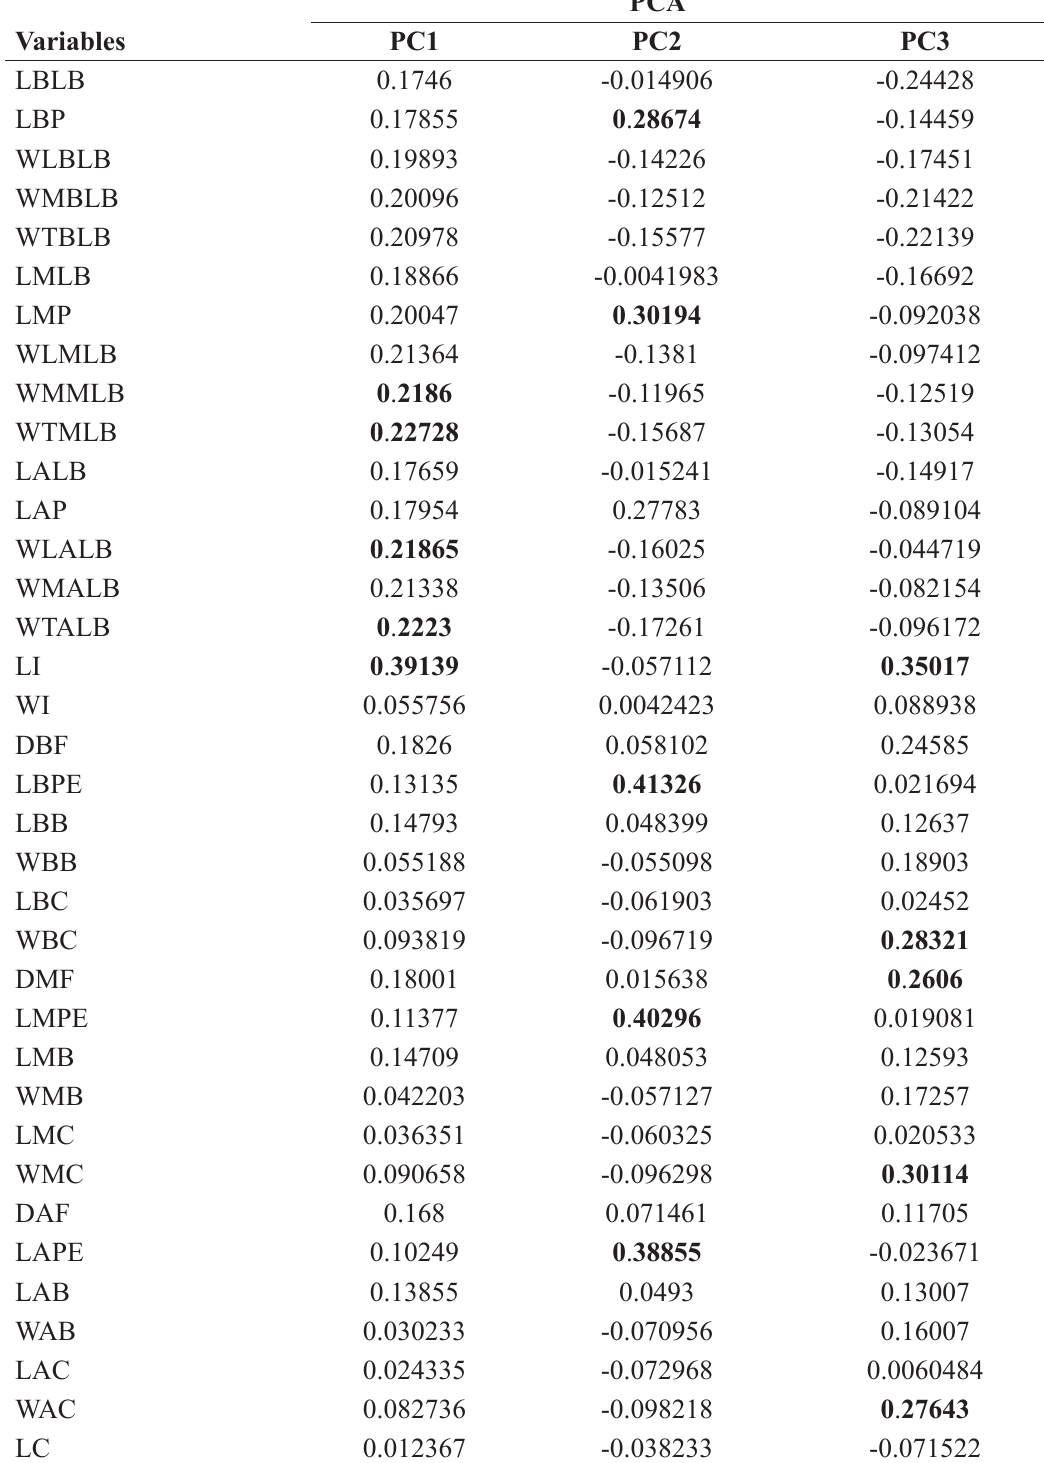
Table 4. Results of Principal Components Analysis (PC1, PC2 and PC3). The five most important (largest) values for each component are in bold. The variable codes are explained in Table